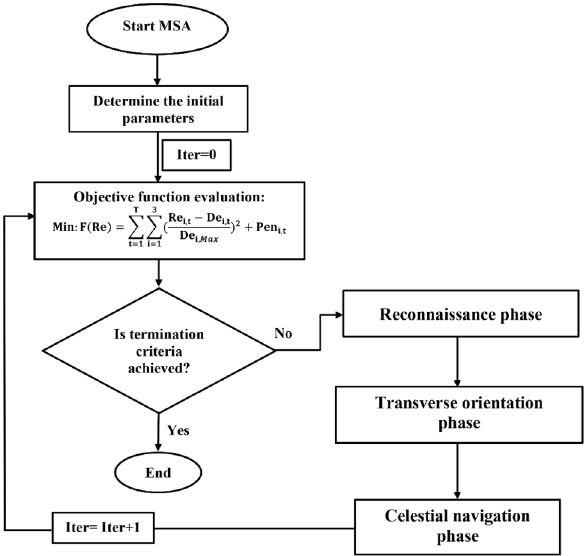
Figure 5. Flowchart of MSA algorithm in the optimal operation of Halilrood multi-reservoirs